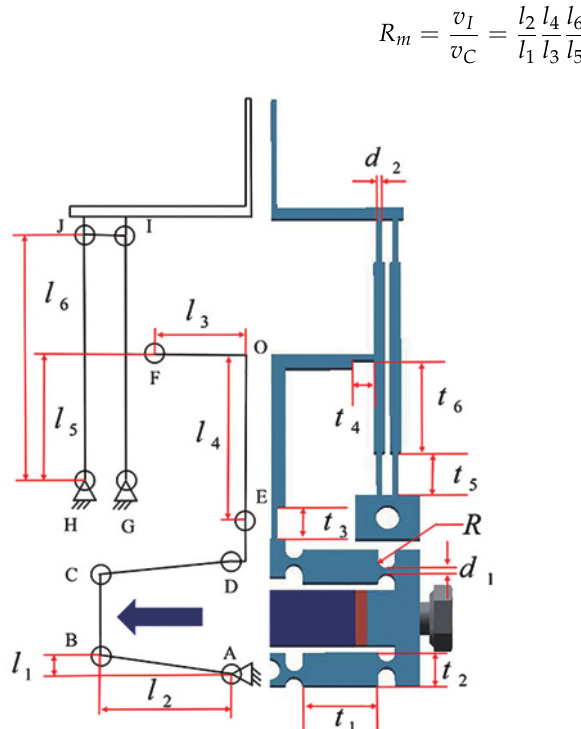
Figure 2. PRBM of the microgripper with some critical geometric parameters.